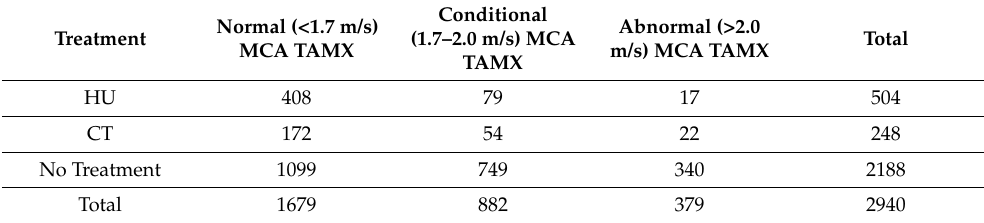
Table 4. Contingency table of TAMX categories. This contingency table displays total number of TAMX measurements categorized by treatment type at the time of TCD, allowing for a comparison of the frequency of normal, conditional, and abnormal TAMX velocities. HU treatment was associated with more “normal” TAMX scores and less “abnormal” TAMX scores when compared with no